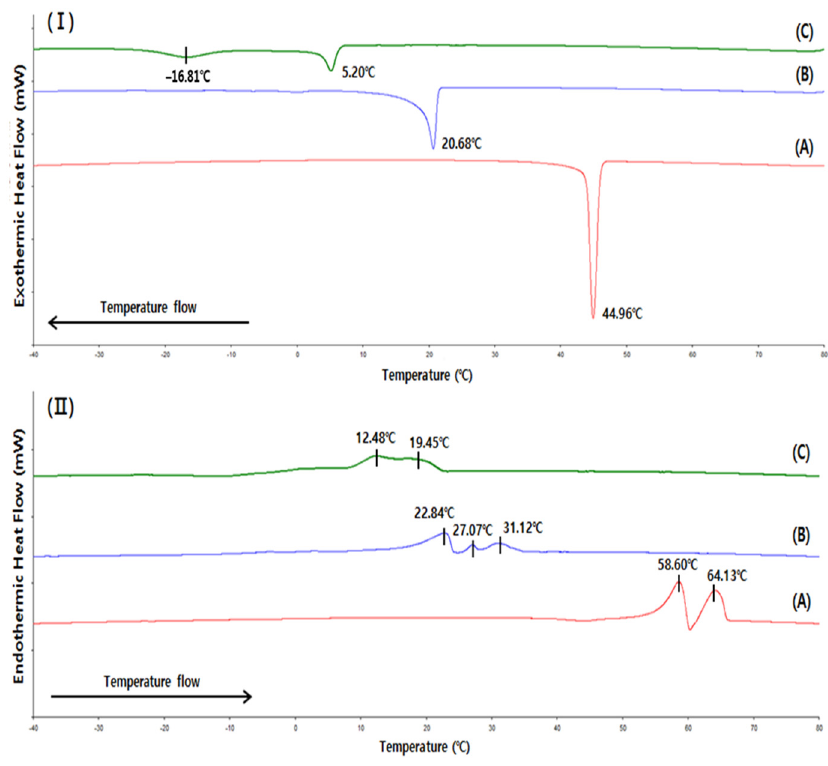
Figure 2. Differential scanning calorimetry (DSC) crystallization ( I ) and melting ( II ) curves of SSS-rich fat ( A ), SSO-rich fat ( B ) and OSO-rich fat ( C ).